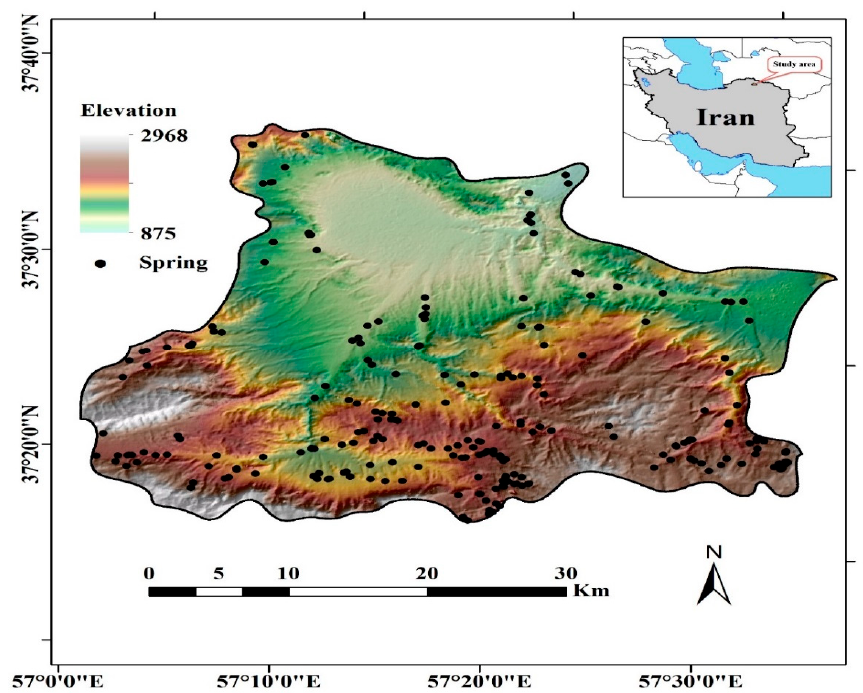
Figure 5. Map showing location of the study area in northern Iran and location of springs within the area.